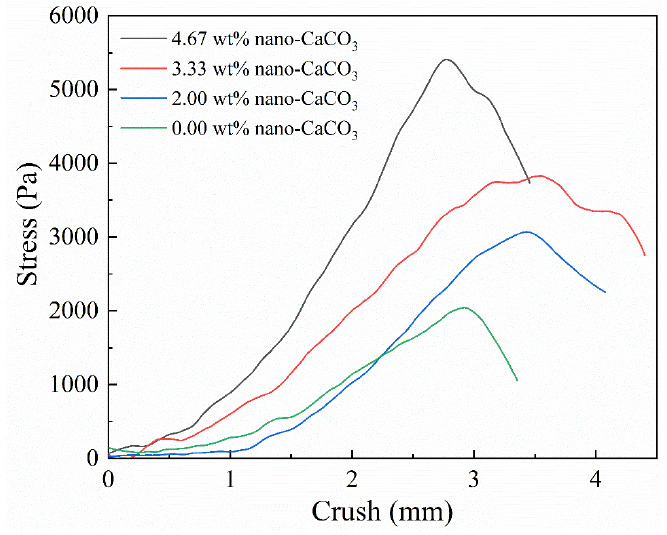
Figure 10. The gel strength of CAAMC after swelling